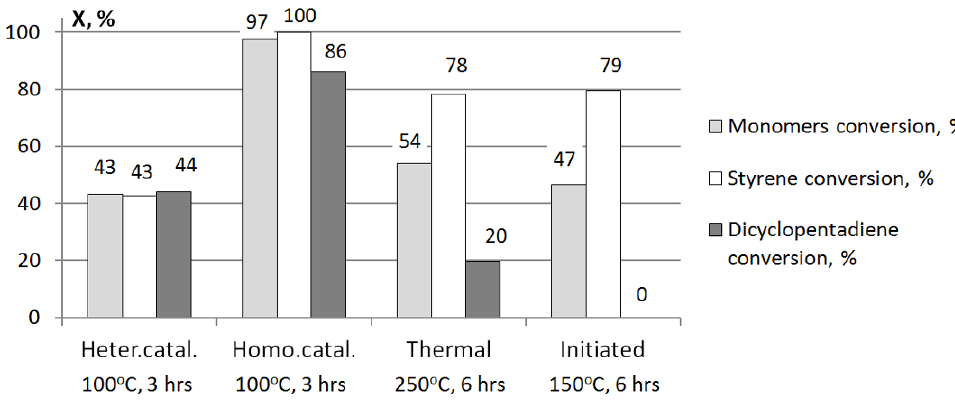
Figure 13. Monomers conversion when using different cooligomerization methods. Table 2. Average number of double bonds per a cooligomer